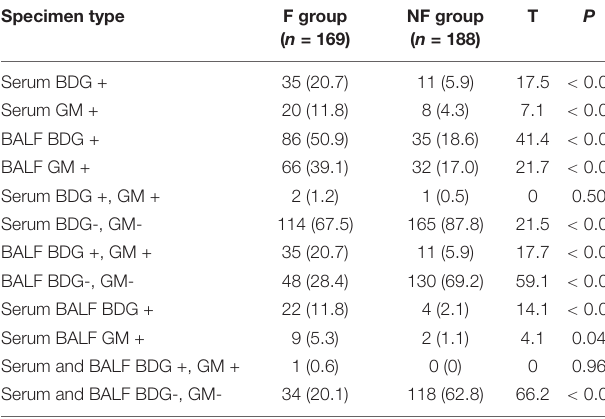
TABLE 4 | Comparison of the serum and BALF BDG and GM statuses between